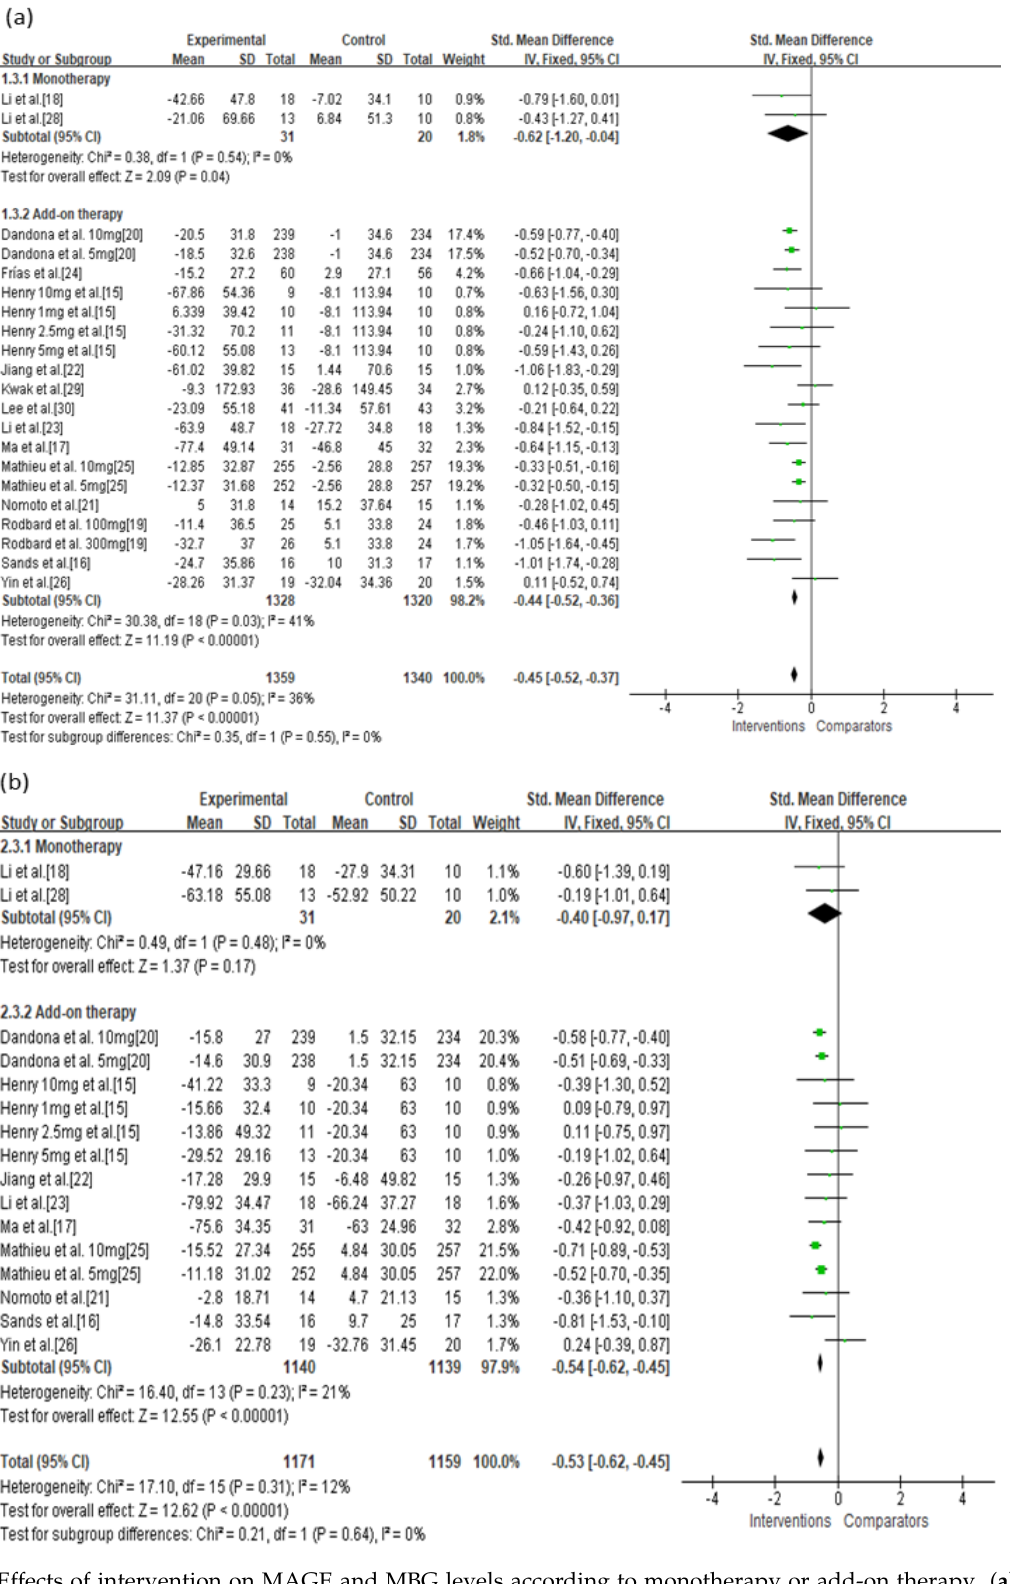
Figure 3. Effects of intervention on MAGE and MBG levels according to monotherapy or add-on therapy. ( a ) MAGE; ( b ) MBG level. MAGE, mean amplitude of glycemic excursion; MBG, mean blood glucose; GLP-1, glucagon-like peptide 1; SGLT-2, sodium-glucose cotransporter 2. Green squares suggested measure of effect for each of included studies, and black diamond represented as meta-analyzed measure of effect. Bold letters indicated a category or subtotal of each subgroup and overall